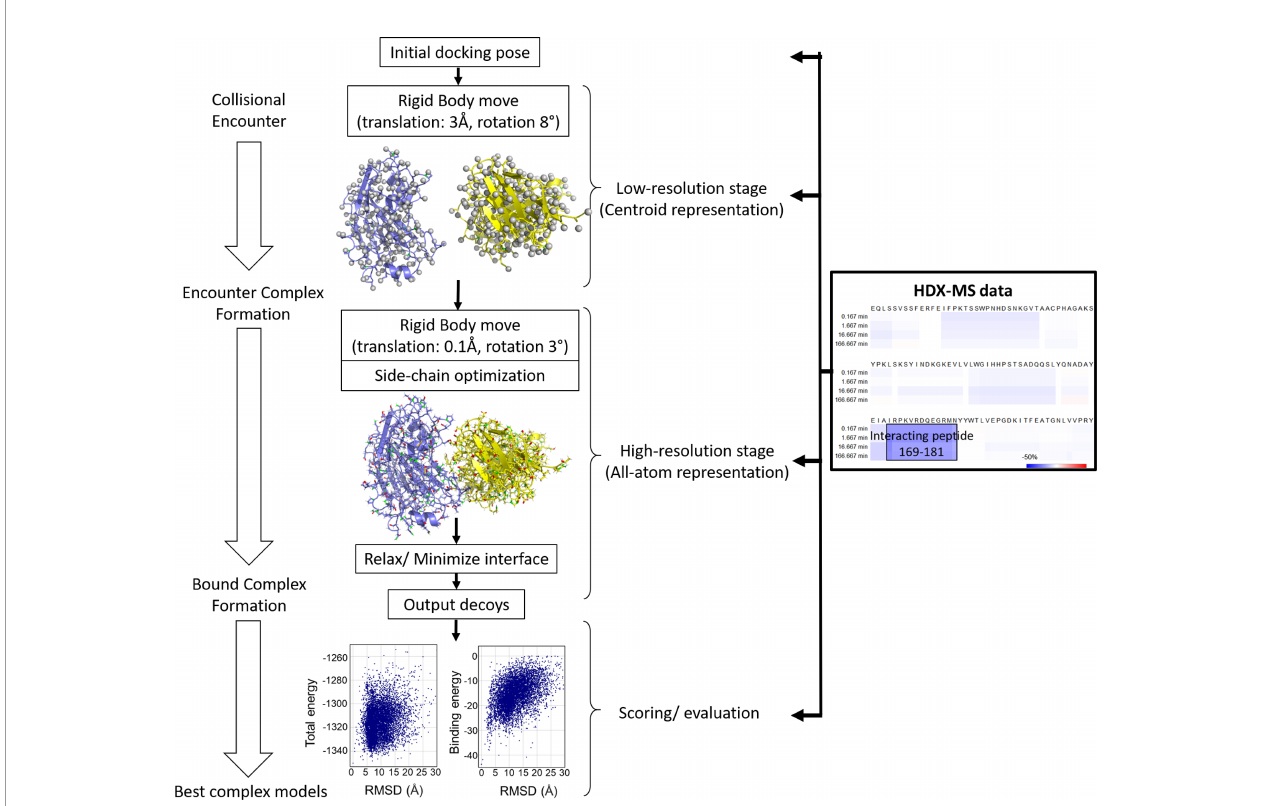
FIGURE 5 | The protein-protein docking procedure from RosettaDock – a multiscale Monte-Carlo based algorithm with different stages for HDX-MS data to be incorporated. HDX-MS data can be applied to the sampling stage (including the arrangement of the starting pose, low-resolution docking, and high-resolution docking) as well as the scoring stage. Figure is adapted from